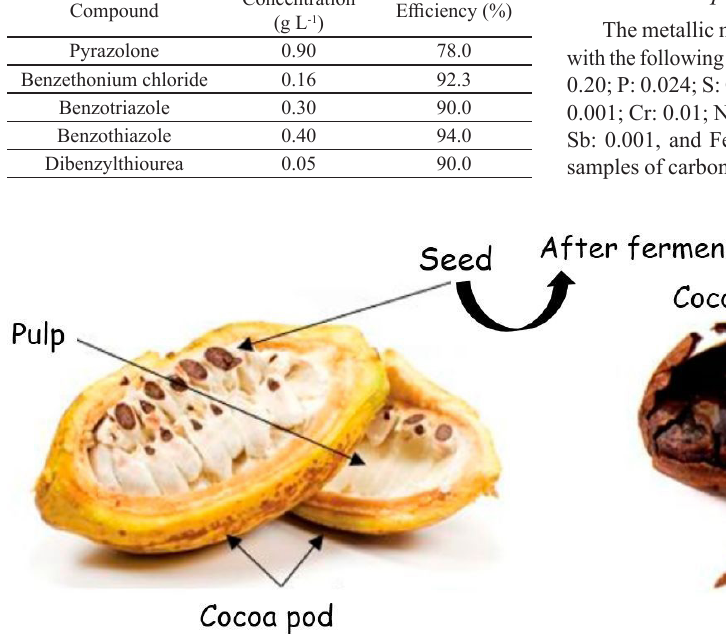
Table 1. Concentration and efficiency of commercial corrosion inhibitors for carbon steel in HCl media. Compound